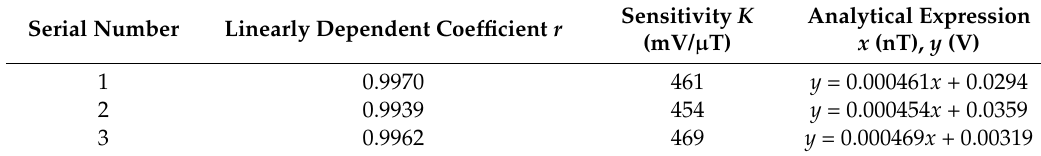
Table 4. Results of the three